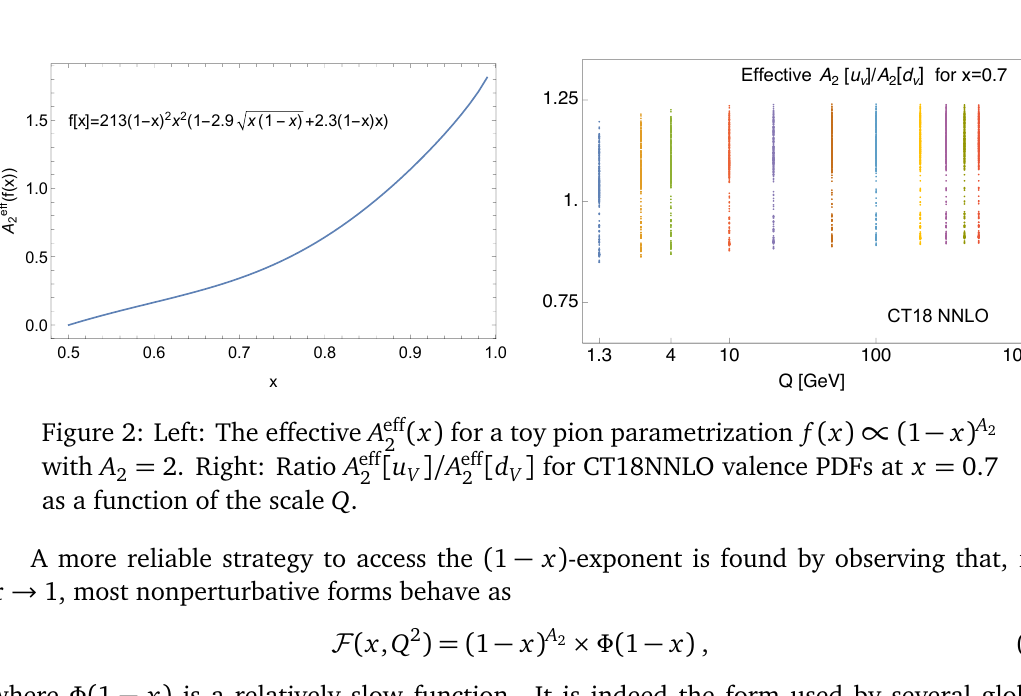
Figure 2: Left: The effective A eff = 2. Right: Ratio A eff with A 2 as a function of the scale Q